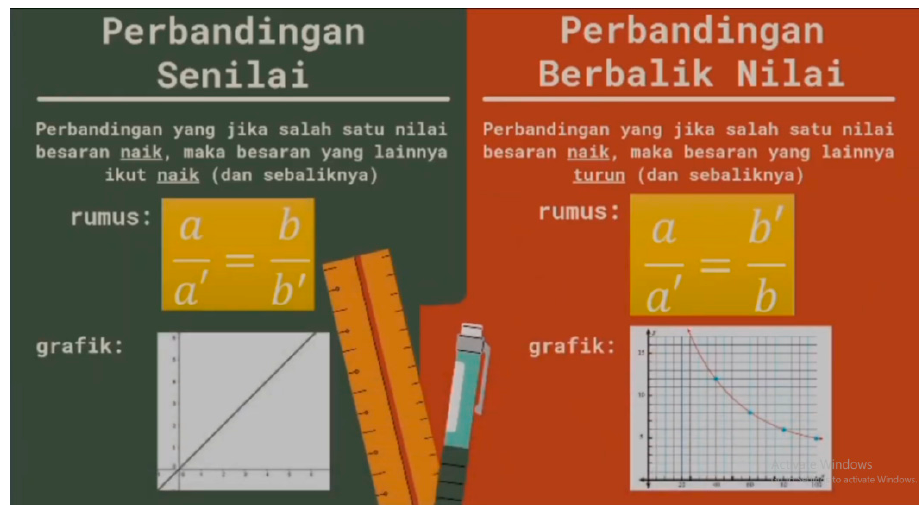
Figure 1. Part of micro-lectures that promote students to analyze and differentiate direct and inverse proportion topics independently.